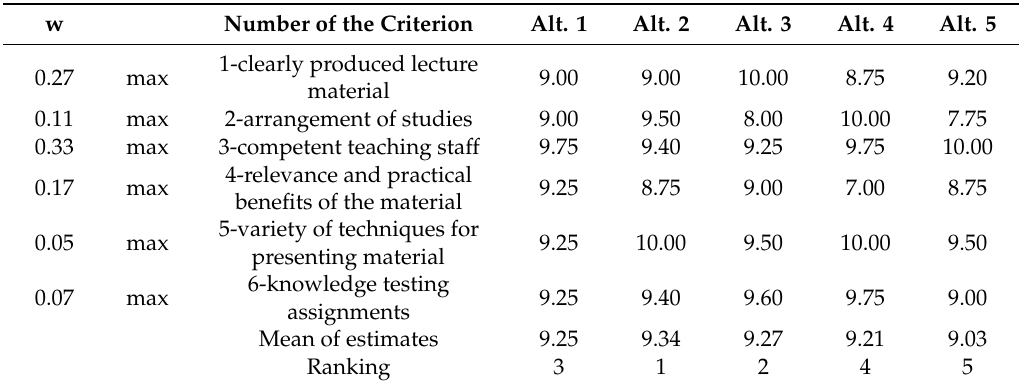
Table 1. Data on assessing course